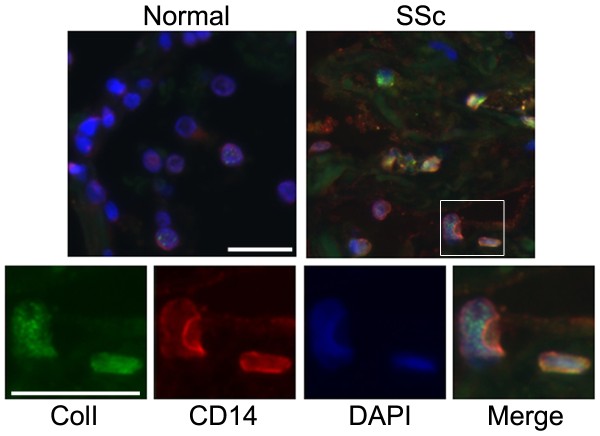
CD14+/ColI+ cells are present in SSc-ILD lung tissue. Fixed, paraffin-embedded adult lung tissue sections from normal and SSc-ILD subjects were stained for CD14 and ColI. Nuclei were stained with DAPI (blue). Top: low-magnification images showing SSc-ILD adult lung tissue. Bottom: high-magnification images showing SSc-ILD adult lung tissue. The portion of the low-magnification image presented at high magnification is boxed. ColI, green; CD14, red. Note that CD14+/ColI+ cells are present in SSc-ILD lung tissue, but not in normal lung tissue. Bar = 10 μm.